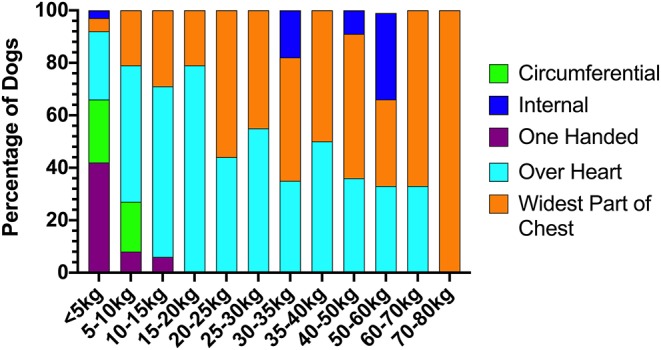
Chest compression techniques applied to dogs during CPR according to body weight. CPR, cardiopulmonary resuscitation.